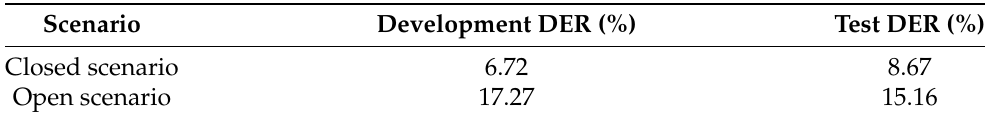
Table 1. DER (%) results for the Albayzín 2020 corpus, including results for both development and test subsets.